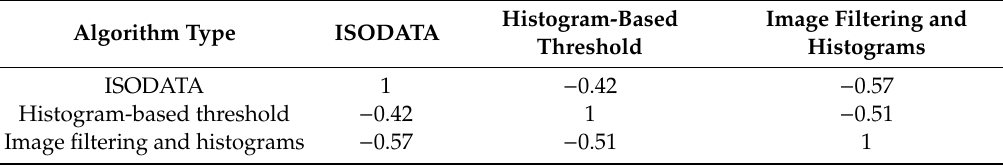
Table A5. The Pearson correlation coe ffi cients of the di ff erent image binarization algorithm using IS. It confirms that our sample accuracy was